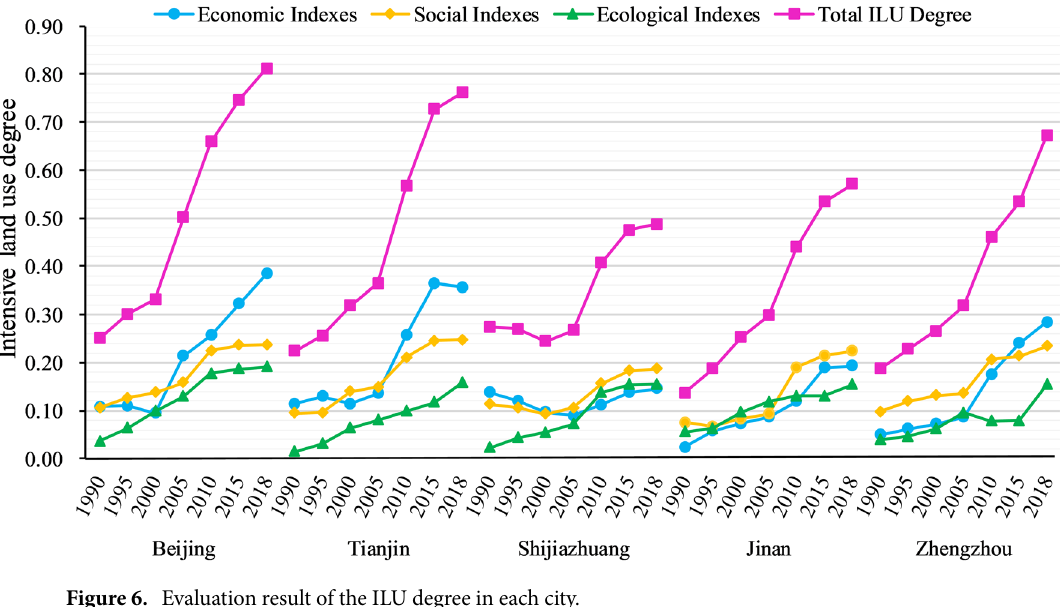
Figure 6. Evaluation result of the ILU degree in each